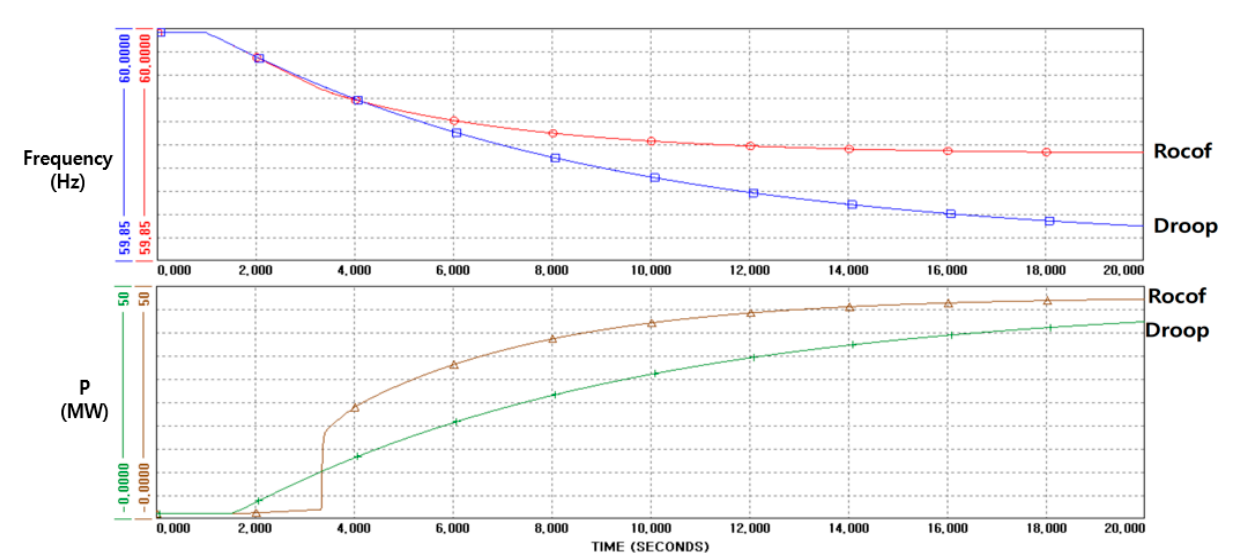
Figure A6. Examples of ESS output characteristics.